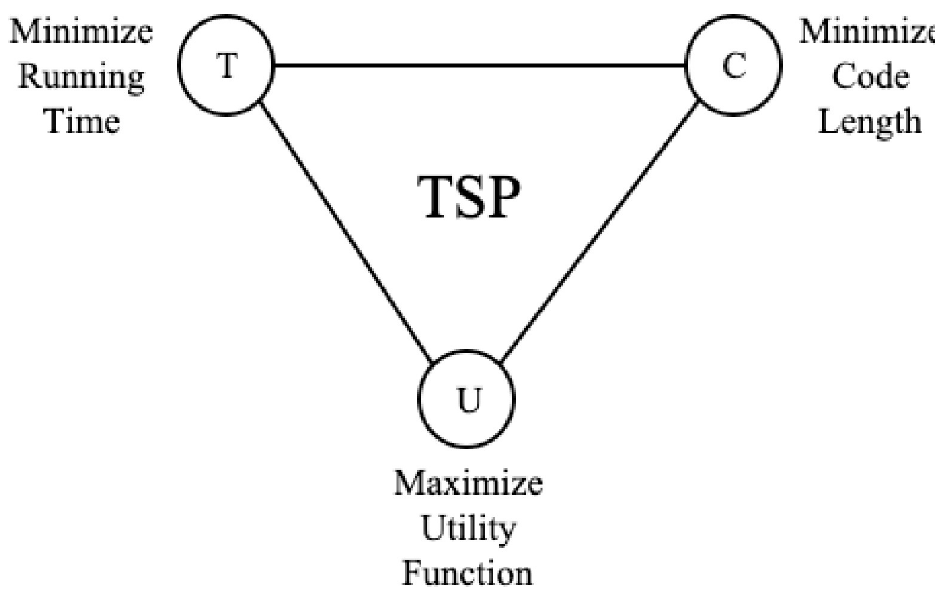
Fig 24. TSP target objectives.